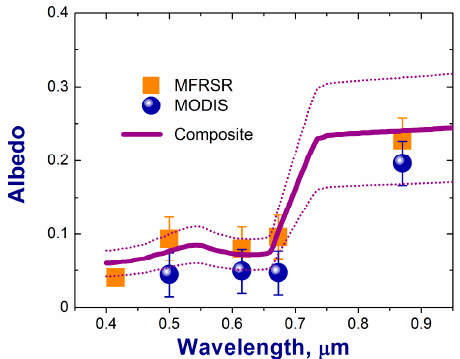
Figure 5. Spectral values for the MFRSR-retrieved (orange squares), MODIS-derived (blue dots) and composite-based (solid violet line) areal-averaged albedos. The MFRSR-retrieved and MODIS-derived mean values are obtained for the 19-month period of interest; their error bars represent the corresponding uncertainties. The uncertainty of the composite method is shown by the dotted violet lines.